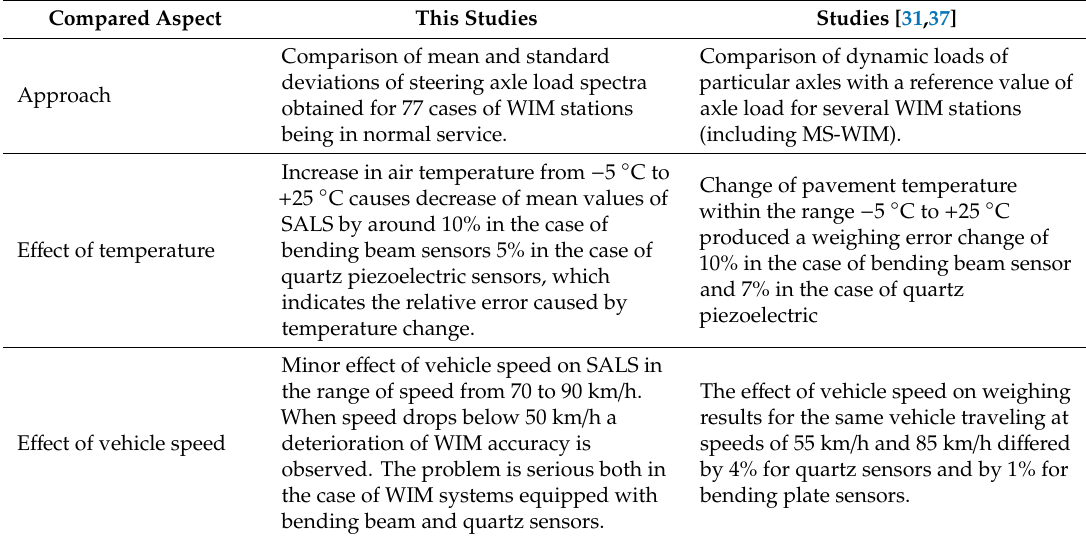
Table 2. Comparison of methodologies and results obtained from presented analysis to results obtained from previous works